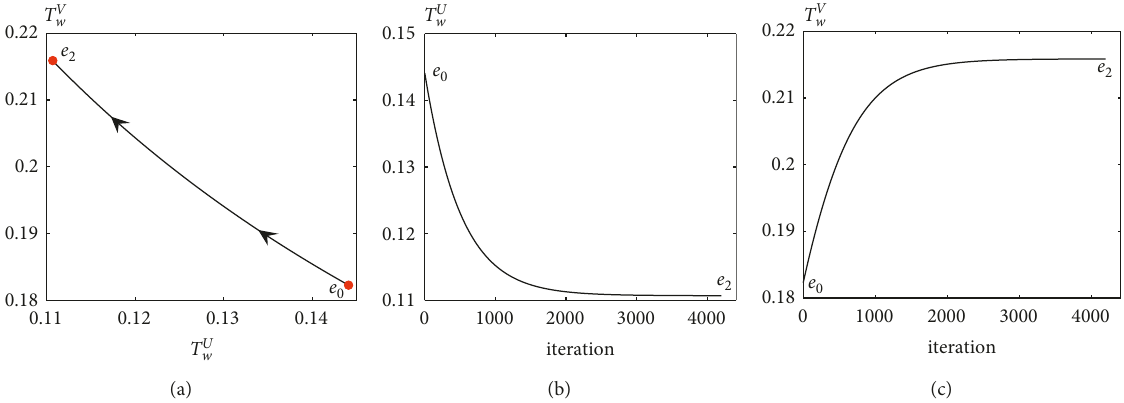
� 10 min ( θ U � 1 , θ V � ( 1/18 . 8222 )) . (a) Transition path. (b) Evolution of T U i